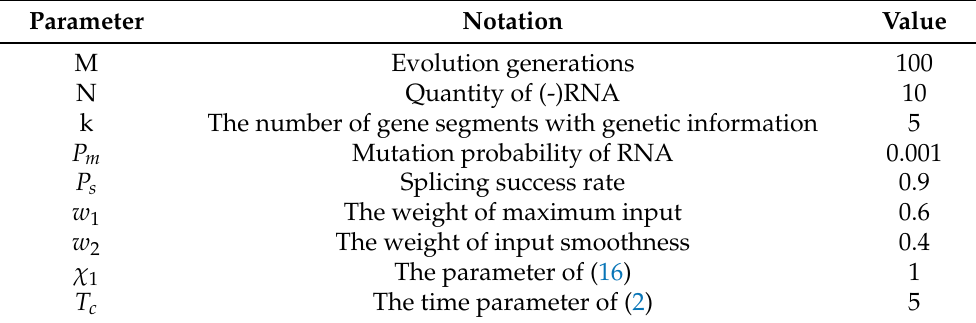
Table 1. The parameters of dsRNA Splicing Evolutionary